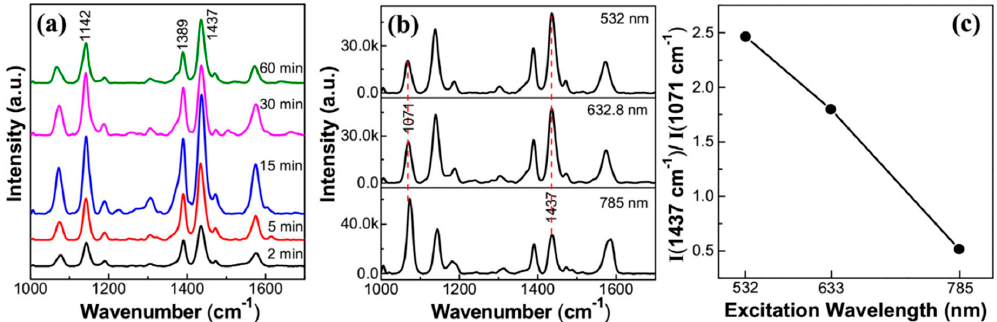
different UV irradiation time. ( b ) Laser wavelength-dependent SERS spectra on 15 min AgNPs-TiO 2 film hybrid. ( c ) Relative ratio between intensities at 1437 cm − 1 and 1071 cm − 1 , with different excitation